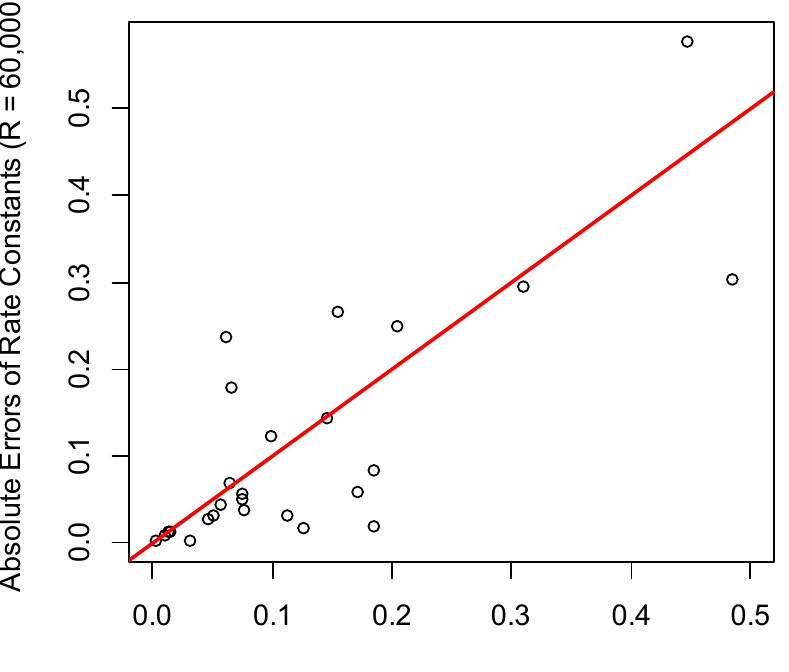
Figure 6. The scatter plot of the absolute values of the differences between each setting of the resolution (R = 30,000 and 60,000) and the corresponding rate constants from the QToF data.